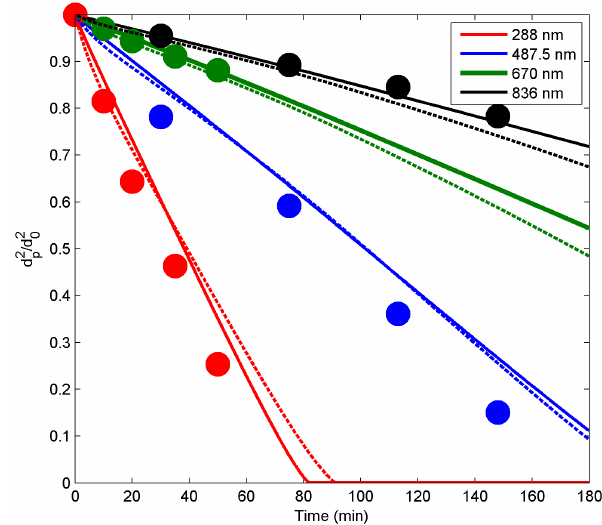
Figure 4. Modelled and measured (Vaden et al., 2011) evaporation losses of DOP particles of different initial diameters. The model results are from simulations with (1) Eq. (30) and a laminar layer width of 0.1cm adjacent to the charcoal denuder (solid lines) and (2) Eq. (31) and a laminar layer of 0.6cm (dashed lines). The mea- surements are given by the solid circles. In the model the DOP mass accommodation coefficient was